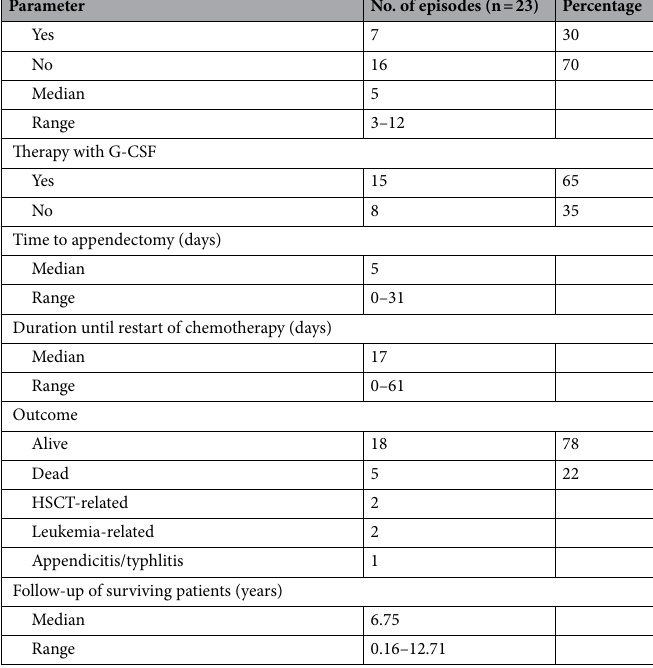
Table 1. Initial characteristics and laboratory features (A, B) and therapy and outcome (C) of the 23 episodes in 21 patients with acute appendicitis. HSCT Hematopoietic stem cell transplantation, No. Number, pts . Patients, WBC White blood cells, ANC Absolute neutrophil count, CT Computed tomography, MRI Magnetic resonance imaging, MRSE Methicillin-resistant Staphylococcus epidermidis , G-CSF Granulocyte-colony stimulating factor. # Acute lymphoblastic leukemia, n = 10; acute myeloid leukemia, n = 5. § Osteosarcoma, n = 1; neuroblastoma, n = 2; Ewing’s sarcoma, n =